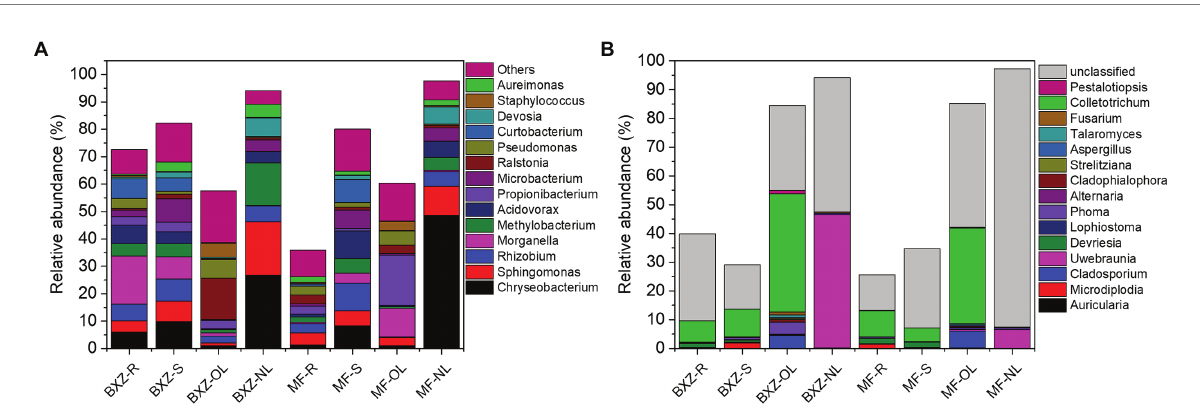
FIGURE 5 Common bacterial (A) and fungal (B) endophytic communities that shared by all tissues across two cultivars (genus level). BXZ_R, BXZ_S, BXZ_OL and BXZ_NL represented root, stem, old leave and new leave samples of BXZ cultivar., while MF_R, MF_S, MF_OL and MF_NL represented root, stem, old leave and new leave samples for MF